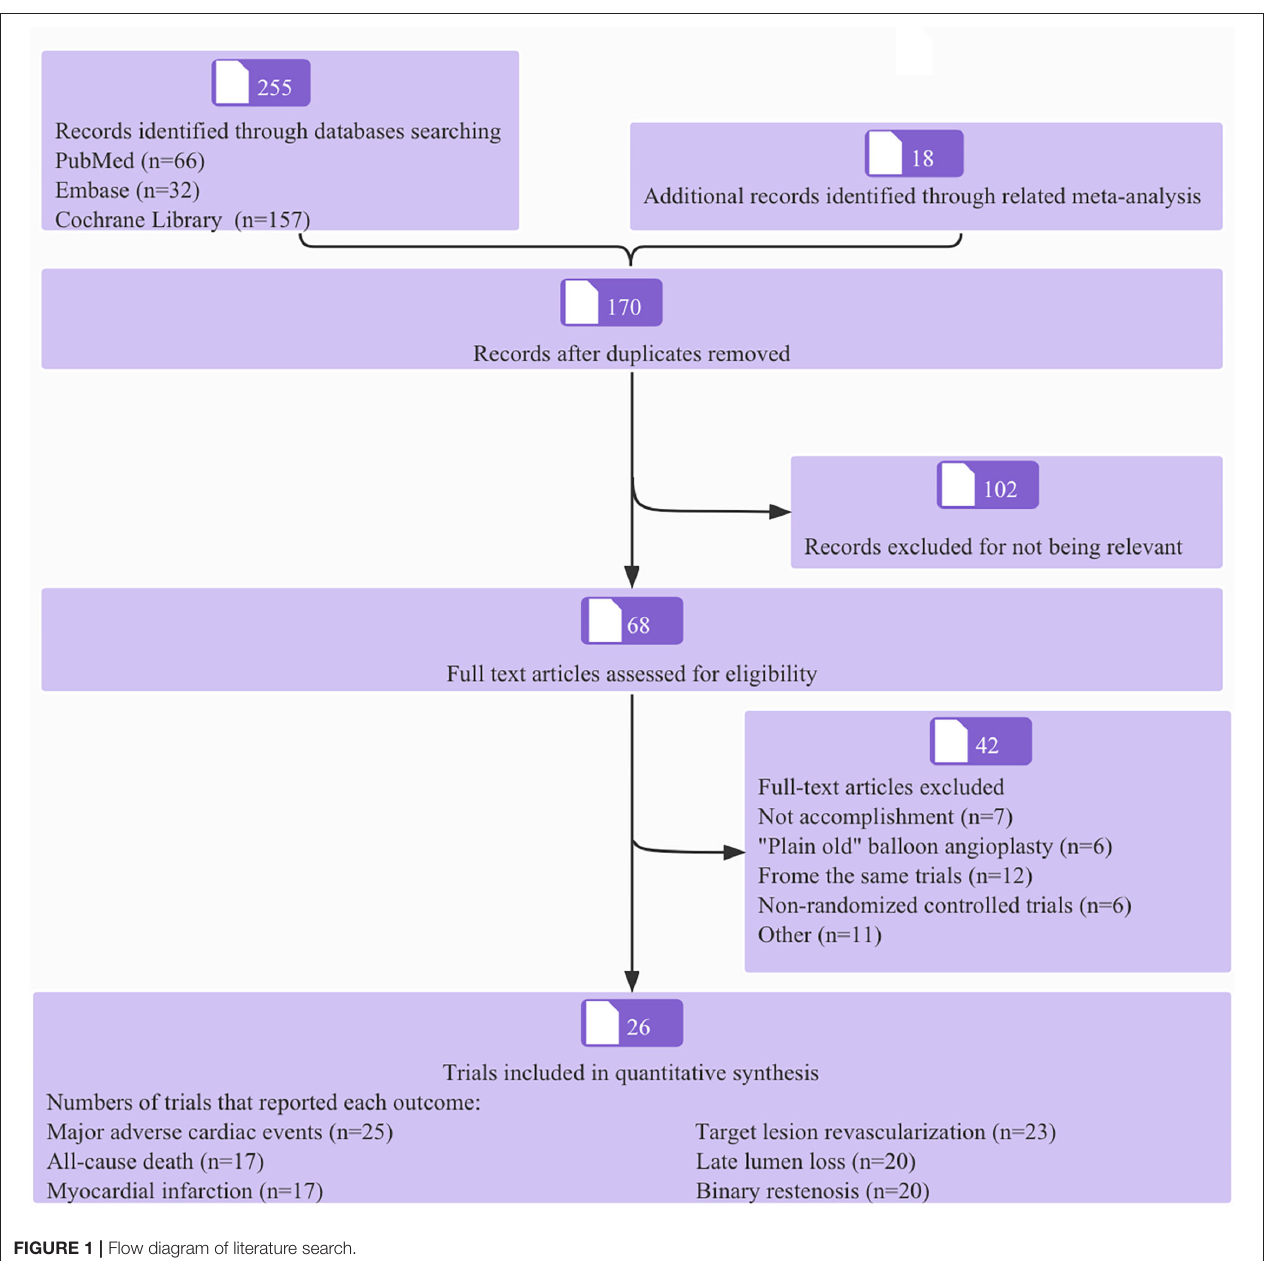
FIGURE 1 | Flow diagram of literature search.